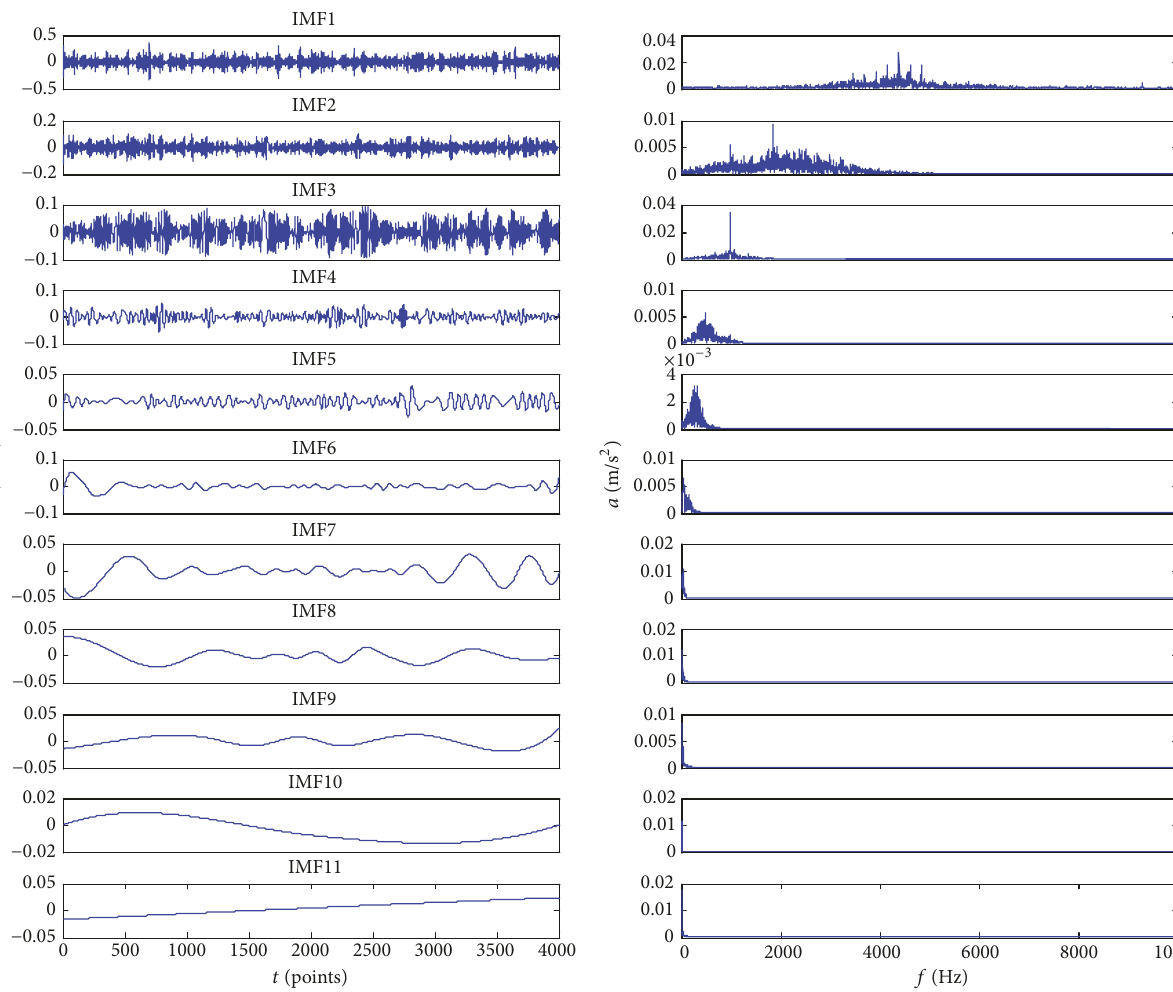
Figure 6: The IMFs and frequency spectrum of